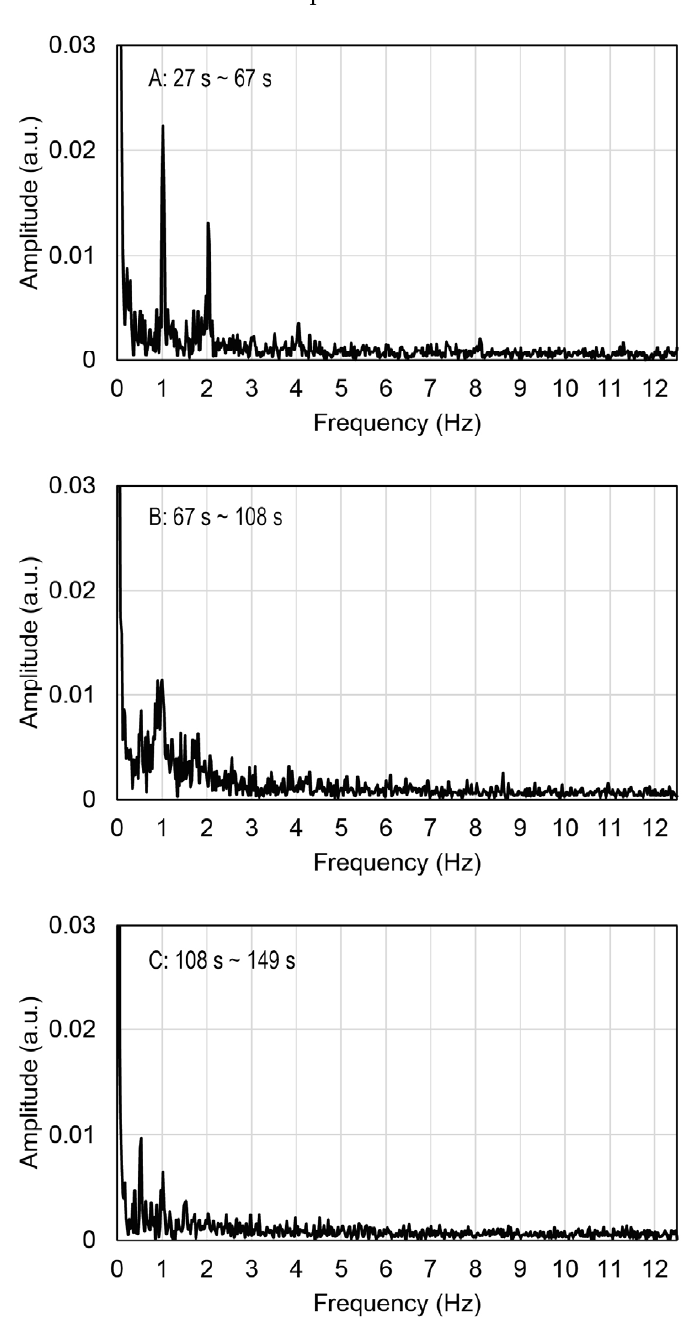
Figure 4. Fast Fourier transform applied to the signals illustrated in Figure